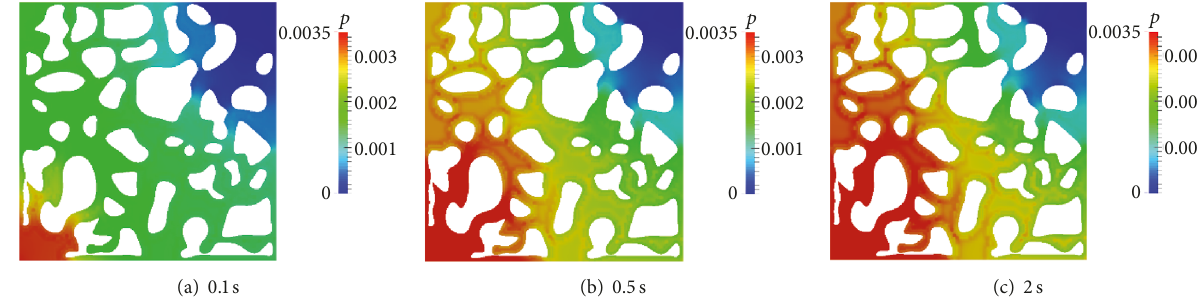
Figure 6: The pressure distribution diagram of the polymer solution injected at different times ( 𝜆 = 0.1 s).